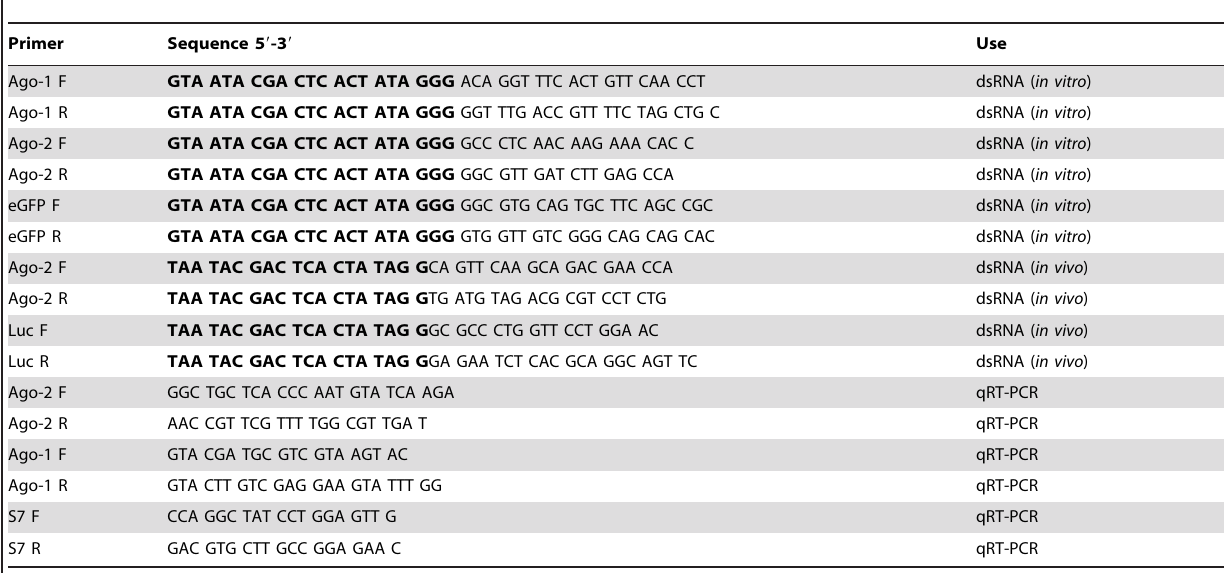
Table 1. Table of all primer